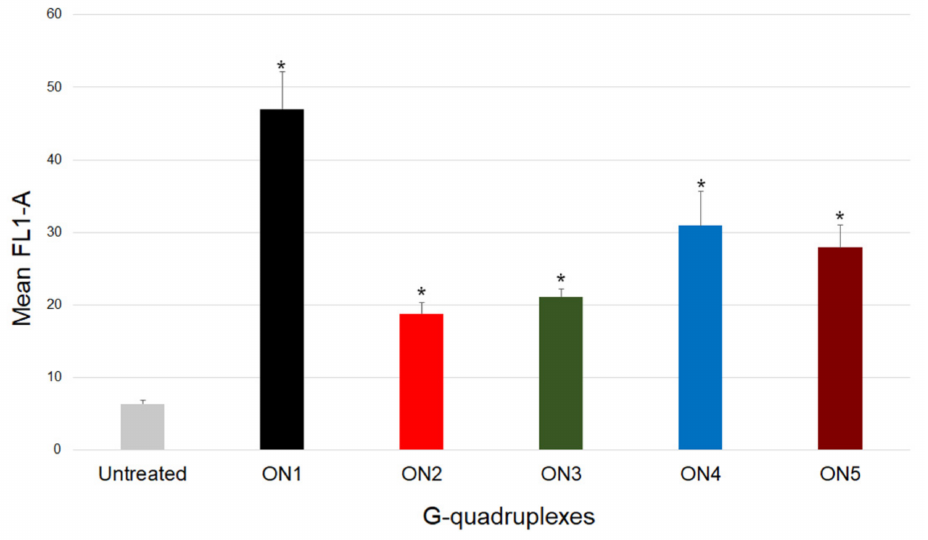
Figure 6. Relative cellular uptake of the oligonucleotides ON1 to ON5 studied at 10 µ M in HeLa cells. * p < 0.001 by one-way